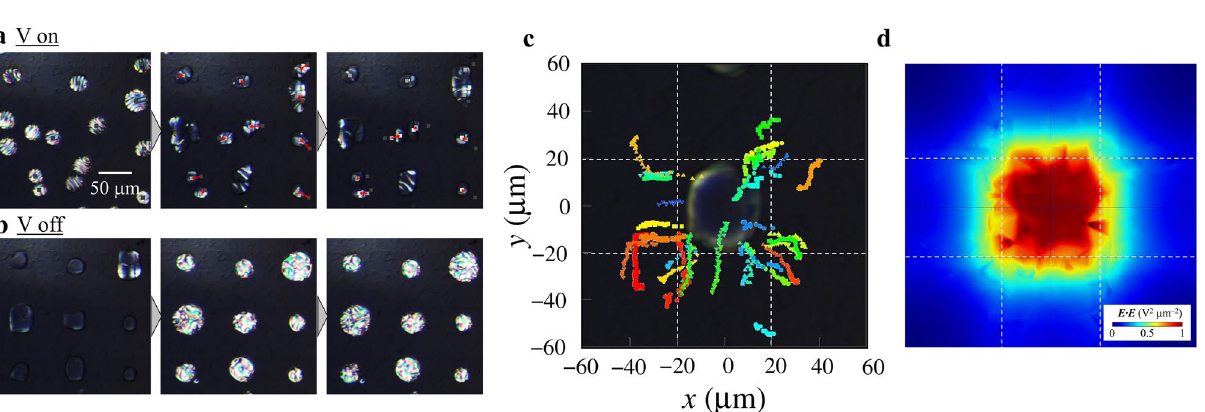
Figure 5. Transportation of LCDs within the microcapacitive device. (a) POM images of LCDs after voltage application. Snapshots were taken every 1/3 s. We highlighted the centers of gravity of LCDs and deviation from 1/3 s in square markers and red arrows, respectively. (b) POM images of LCDs after removing the voltage. Images were taken every 1 s. (c) Trajectories of LCDs in the microcapacitor. We measured the centers of gravity of LCDs every 0.2 s and superimposed the trajectories on a typical POM image. (d) The electrostatic energy distribution in the microcapacitive device. White dashed lines represent the ITO